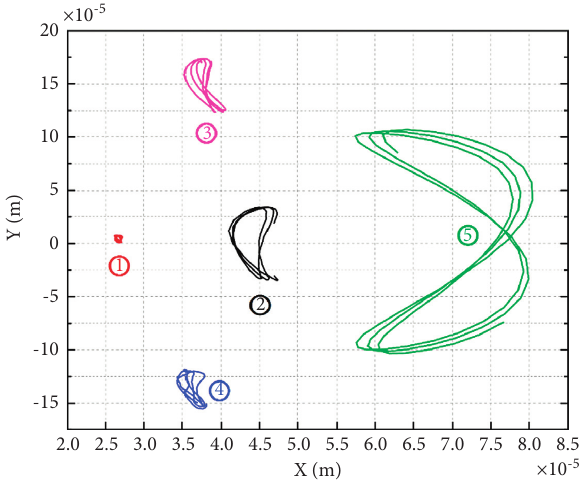
Figure 30: Vibration displacement curves of different tube bundles with the pitch-diameter ratio of